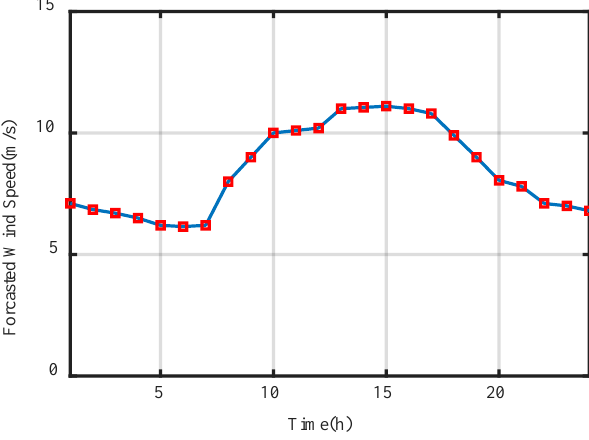
Figure 8. Wind speed forecast in the region for a 24-h period.